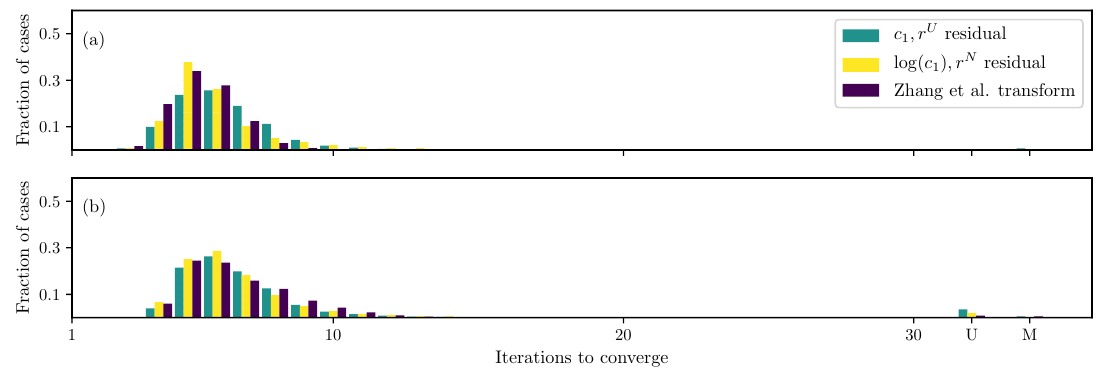
Figure 9. Iterations required using different formulations for the May-Newman (6) model DC case when ( a ) only c 1 and c 2 are unknown and ( b ) all parameters except the angle θ are